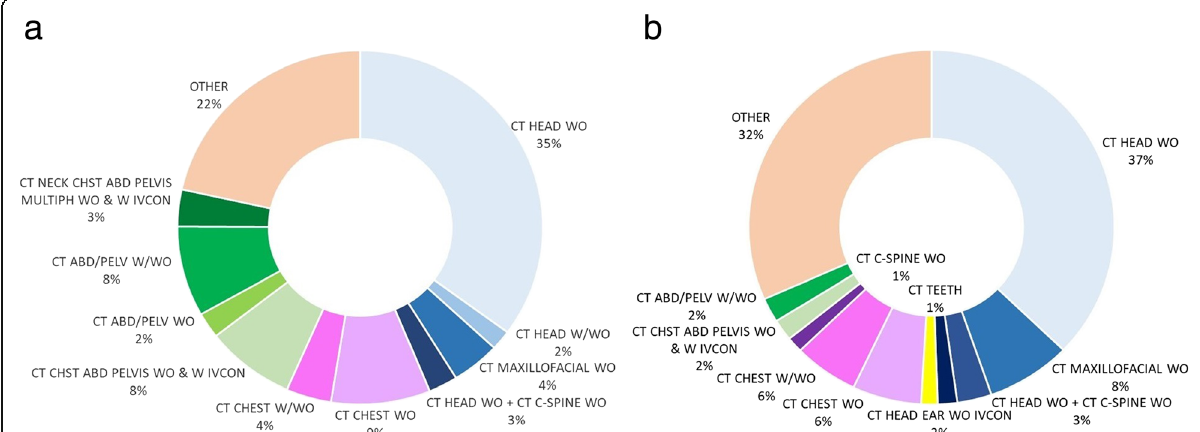
Fig. 3 Percentages of exams within the ten most common study common names in two different age ranges: 18 – 109 ( a ) and 0 – 17 ( b ). The main differences between the two distributions are the presence of many exams with a broad scan length including different anatomical regions in adult pie chart and the almost total absence of exams with contrast agent in paediatric ones. The majority of paediatric exams were in the head region compared to the adult distribution, with more “ CT Maxillofacial WO ” (traumas, sinusitis) and the addition of “ CT Teeth ” . The higher percentage of exams in the “ OTHER ” in the paediatric distribution could be related to the greater difficulty of the diagnosis in the absence of clinical history and with symptoms described by children